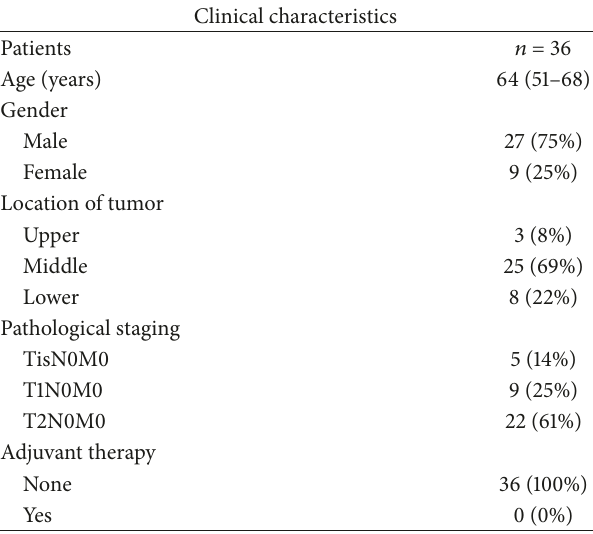
Table 3: Characteristics of patients. Clinical characteristics